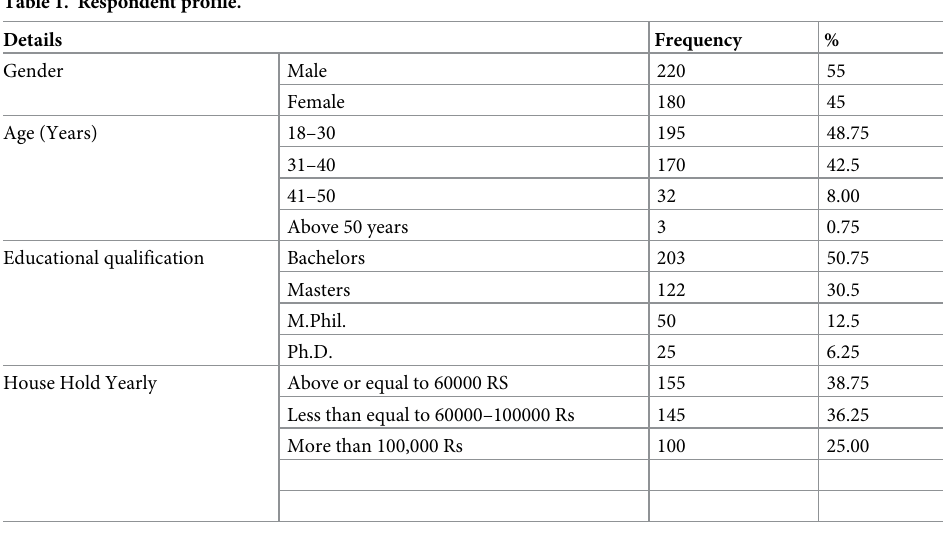
Table 1. Respondent